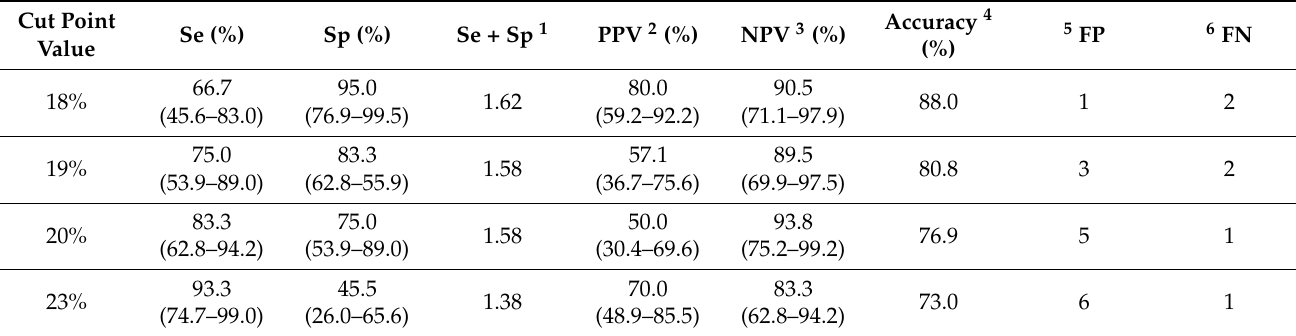
Table 5. Diagnostic test characteristics for colostrum samples from first calf heifers. Sensitivity (Se), specificity (Sp), positive predictive value (PPV), negative predictive value (NPV), accuracy, false positive (FP), and false negative (FN) for different Brix refractometer cut-points compared with 50 mg/mL of IgG as measured by